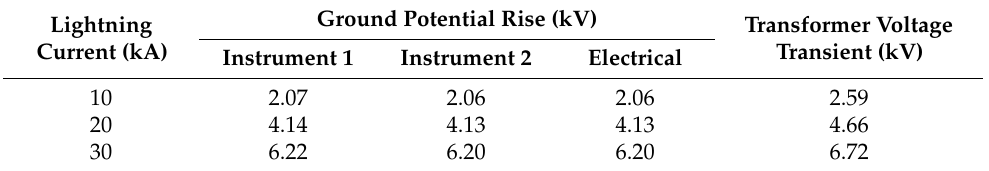
Table 5. Potential rise due to GPR on the system of the equipotential grounding